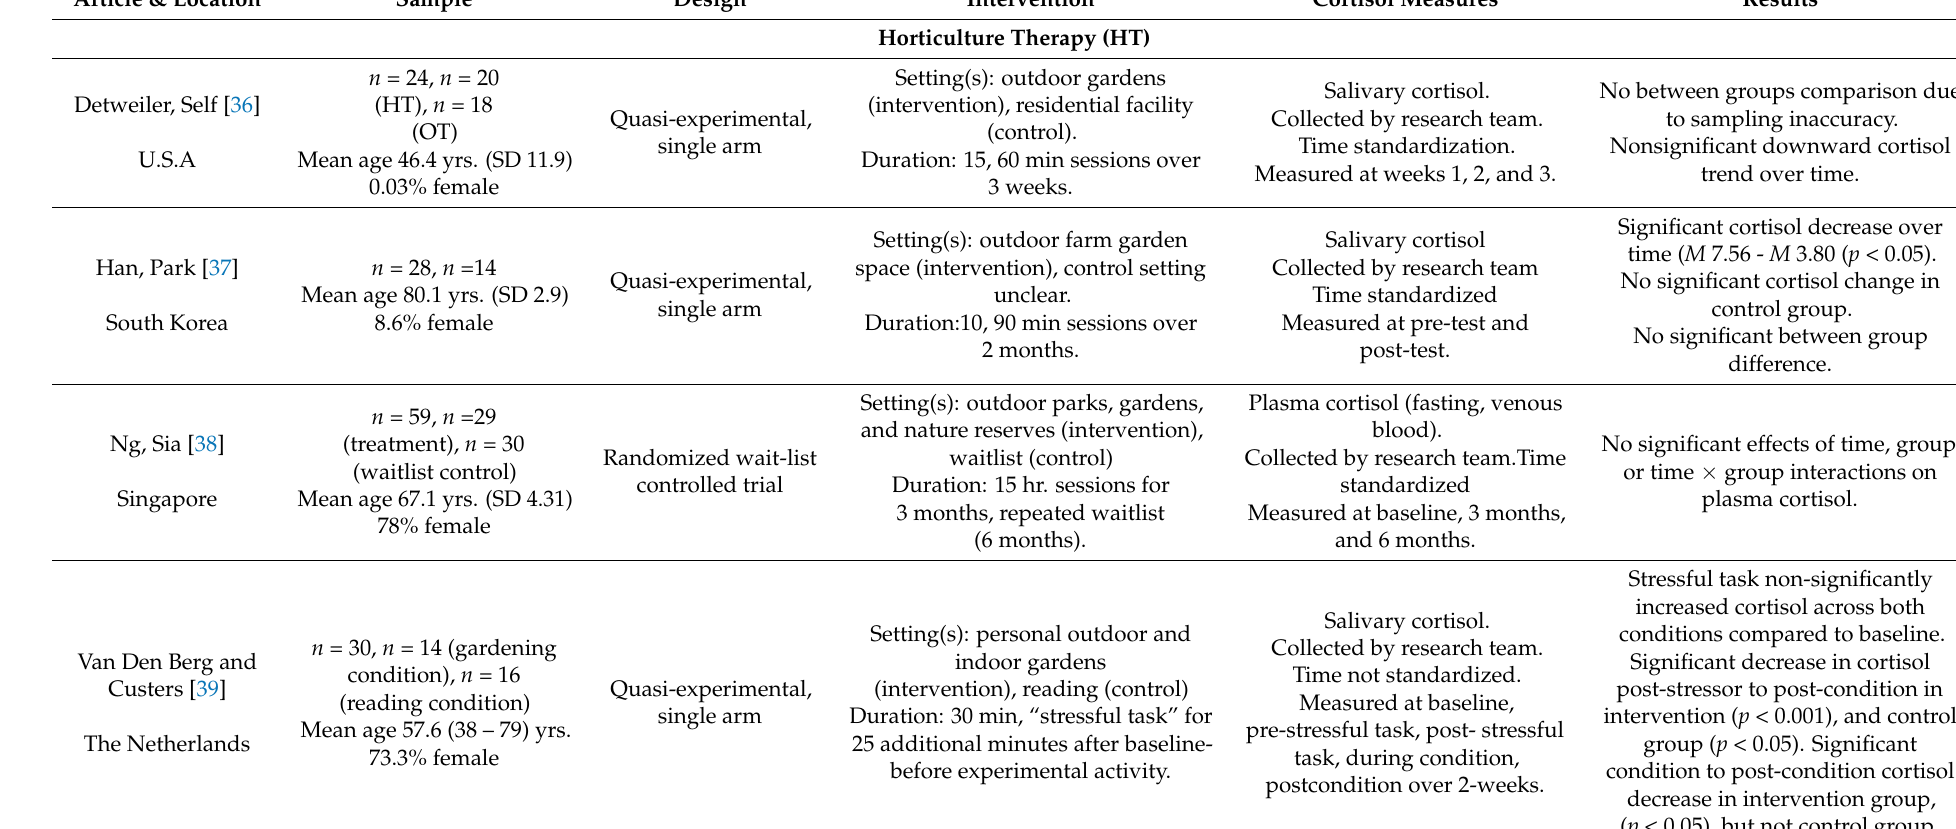
Table 2. Literature